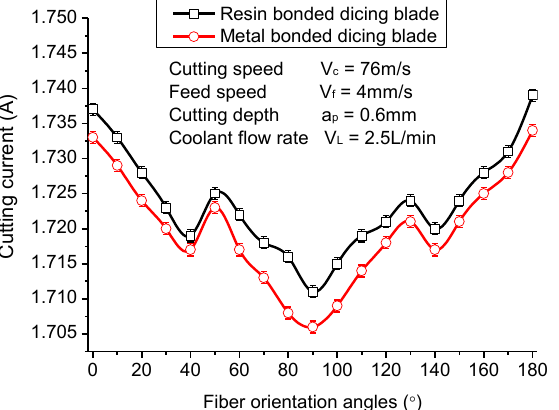
Figure 10. Maximum cutting current varying with fiber orientation.